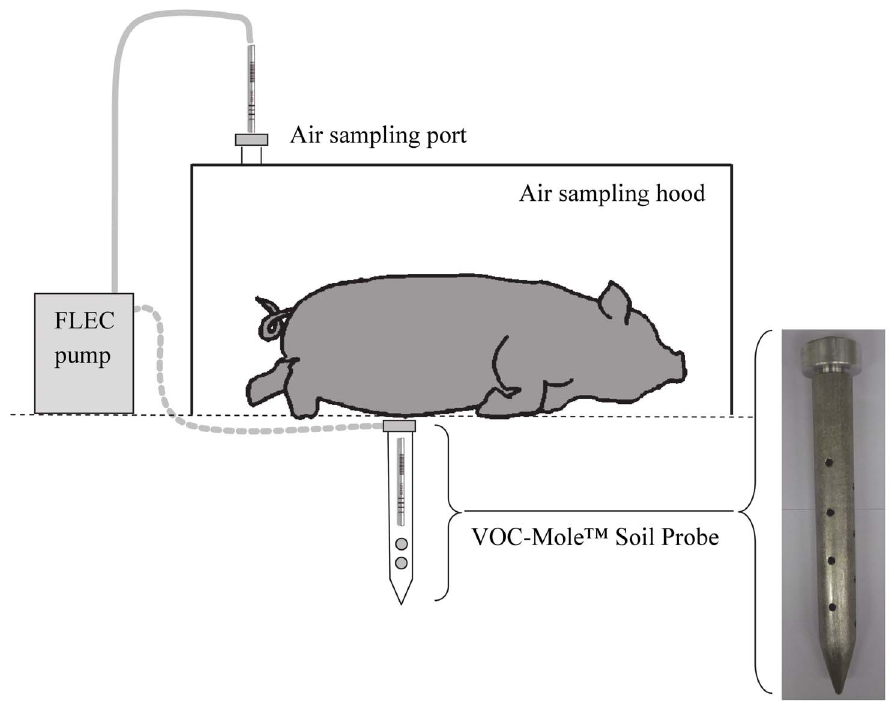
Figure 1. Schematic of VOC sample collection from air and soil surrounding pig carcasses.